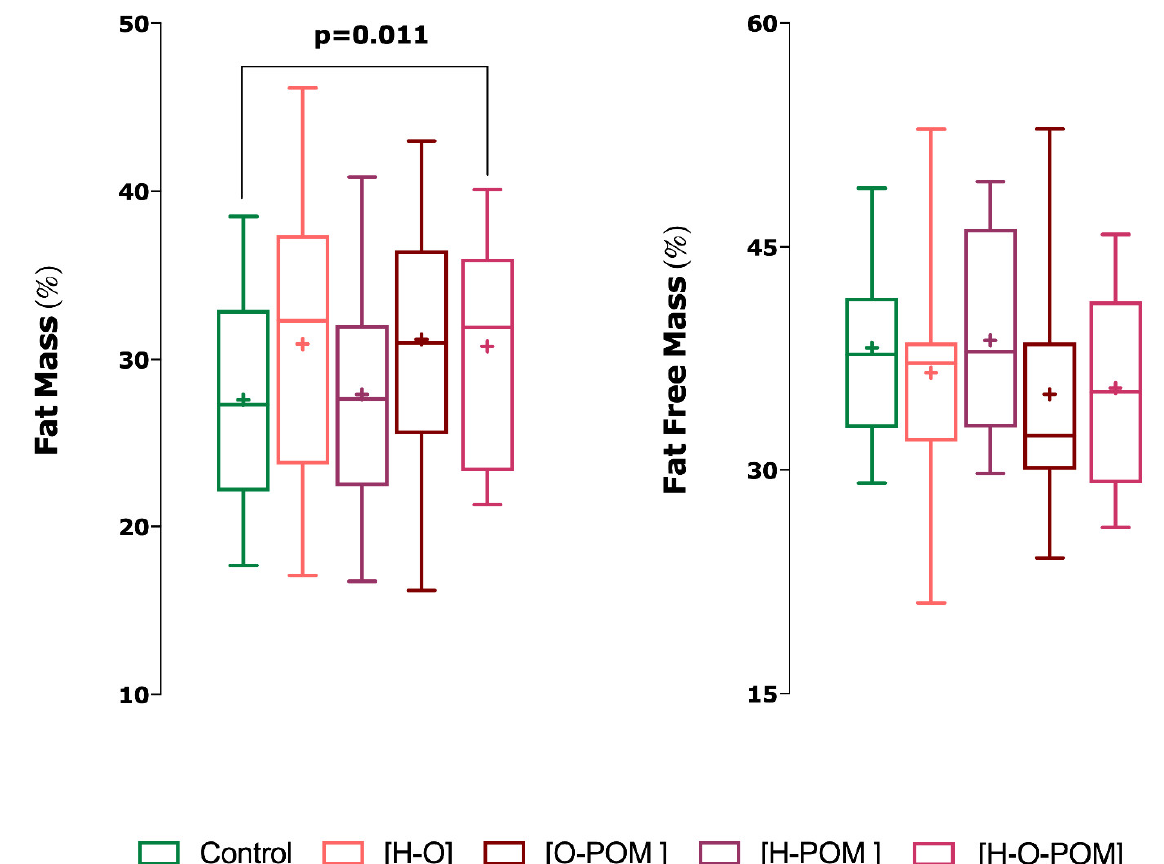
Figure 3. Differences in fat mass and fat-free mass (lean mass + bone mass) between control and PCOS subjects. An ANCOVA was used to assess differences among the groups ( p < 0.05 two tailed). p -value adjusted by Age and Body Mass lndex. Phenotypic: Hyperandrogenism [H]; oligo/amenorrhoea [O]; polycystic ovarian morphology [POM].